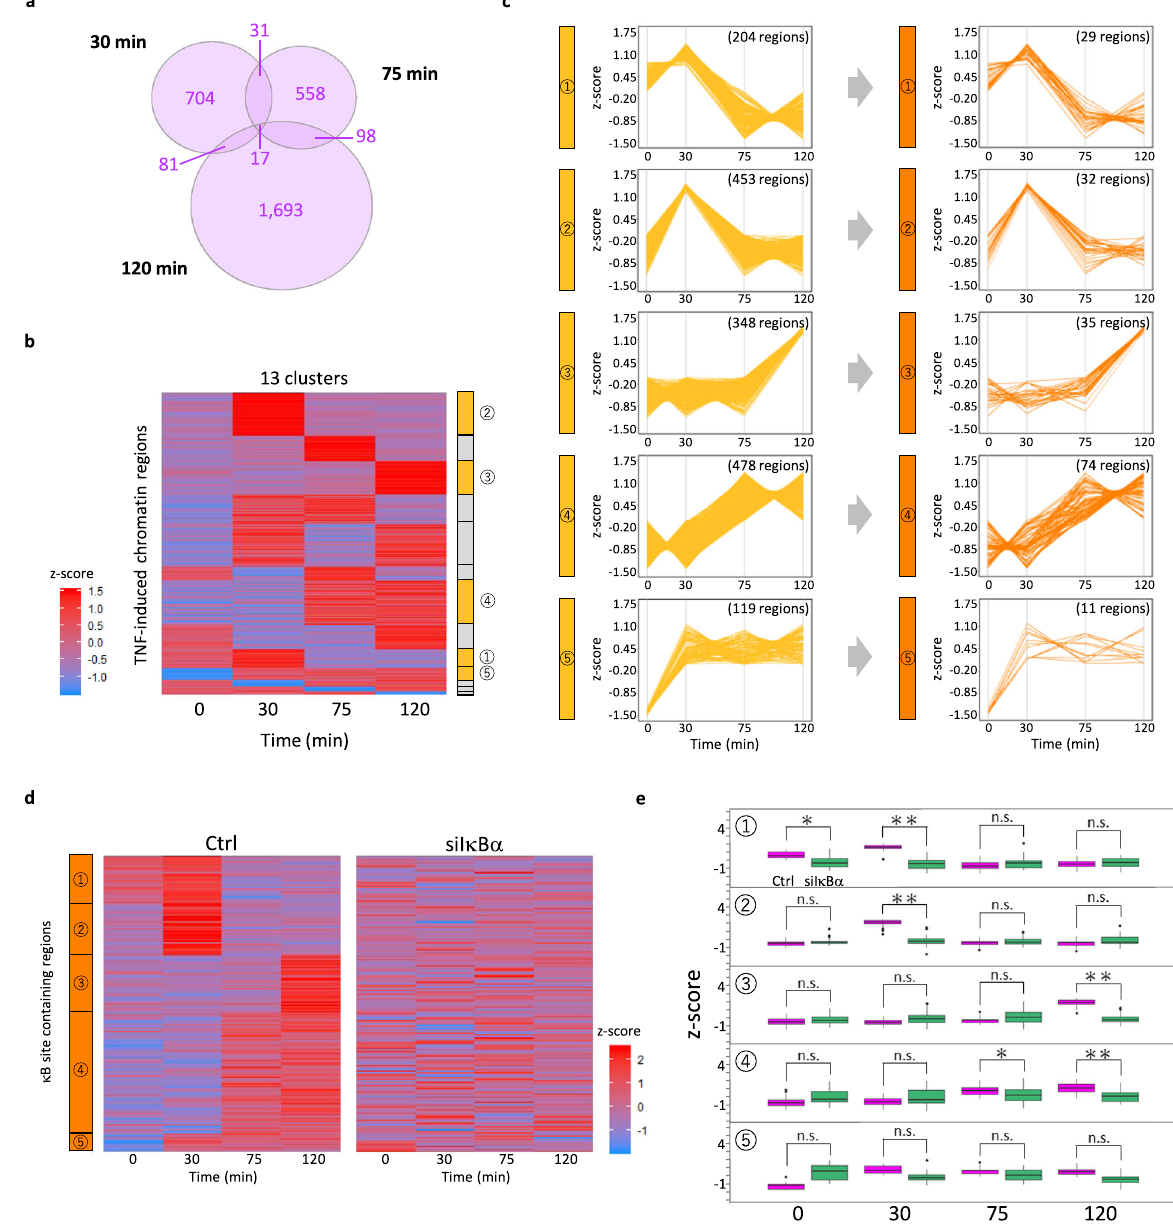
Fig. 2 Dynamics of chromatin accessibility in κ B sites after TNF (tumor necrosis factor) induction. a Venn diagram of the number of TNF- induced chromatin regions at each time point in Ctrl (Control). b Regions in a clustered into 13 time-course clusters. Chromatin accessibility was normalized to z -score, where red shows high chromatin accessibility and blue shows low chromatin accessibility in the heatmap. c Clusters enriched with κ B sites and extracted κ B site detected regions. Time-course chromatin accessibility was z -score normalized for each κ B site-enriched region. Numbers in braces show the number of regions before and after κ B site enriched regions were extracted for each cluster. d Time-course chromatin accessibility in Ctrl and siI κ B α (I κ B α knockdown) at κ B site-detected regions in c . Chromatin accessibility was normalized to z -score, where red shows high chromatin accessibility and blue shows low chromatin accessibility in the heatmap. e Comparison of time-course chromatin accessibility between two conditions at κ B site-enriched regions in d . Statistical tests were performed for chromatin accessibility between Ctrl and siI κ B α at these regions in Ctrl and siI κ B α (* p value < 0.01, ** p value < 0.0001 and n.s.: p value ≥ 0.01 by one-tailed Wilcoxon rank-sum test). The center line indicates the median, the upper and lower hinges indicate the fi rst and third quartiles, the upper whisker extends from the hinge to the largest value no further than 1.5× IQR (interquartile range) from the hinge, the lower whisker extends from the hinge to the smallest value at most 1.5× IQR of the hinge, and the points indicate the single cells were observed at 30 and 120 min of TNF-induced presence and absence of I κ B α , we performed 10-fold cross- regions in the presence of I κ B α , which corresponded to the peaks validation using Bayesian generalized linear model. of nuclear NF κ B abundance in control (Fig. 2d, e, cluster 2 at As a result, substantial statistical signi fi cance ( p value <0.0001) 30 min and cluster 3 at 120 min). However, TNF-induced regions in from aggregated cells and classi fi cation accuracy of >60% from